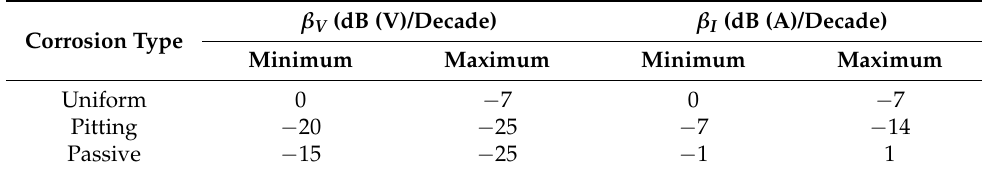
Table 6. β intervals to indicate the type of corrosion.